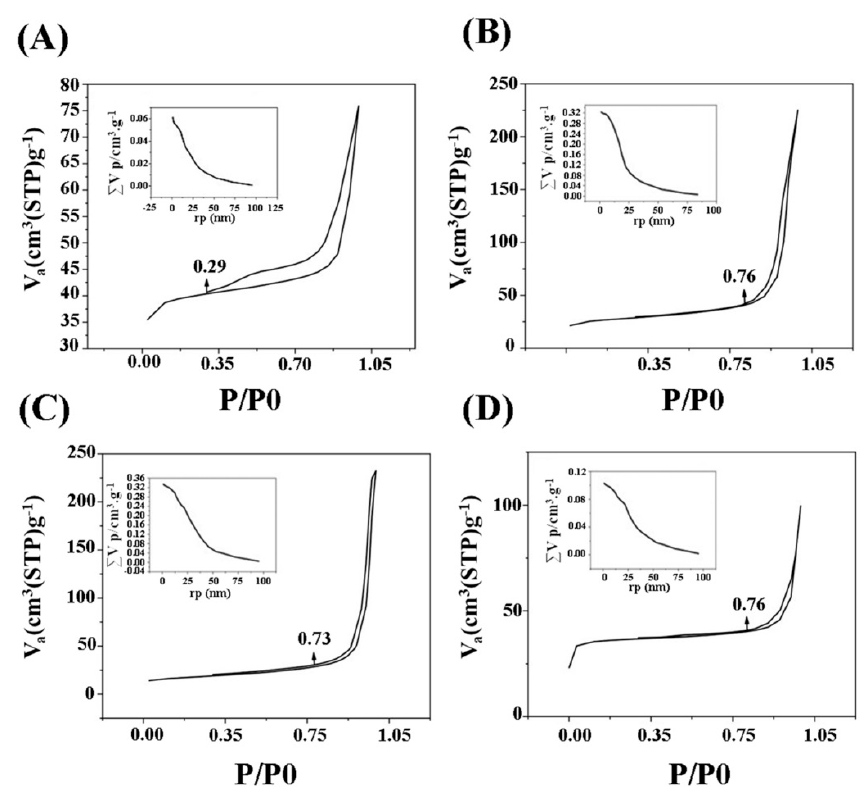
Figure 4. BET / BJH analysis of the synthesized MBGs. Ca-MBG ( A ), Sr-MBG ( B ), Ca-Co-MBG ( C ), and Sr-Co-MBG ( D ).